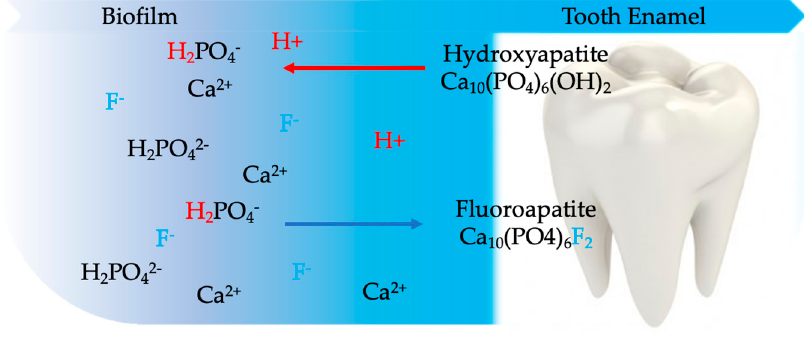
Figure 1. When the pH drops below 5.5, the biofilm fluid becomes undersaturated with phosphate ion and enamel dissolves to restore balance. When fluoride (F − ) is present, fluorapatite is incorporated into demineralized enamel and subsequent demineralization is inhibited.